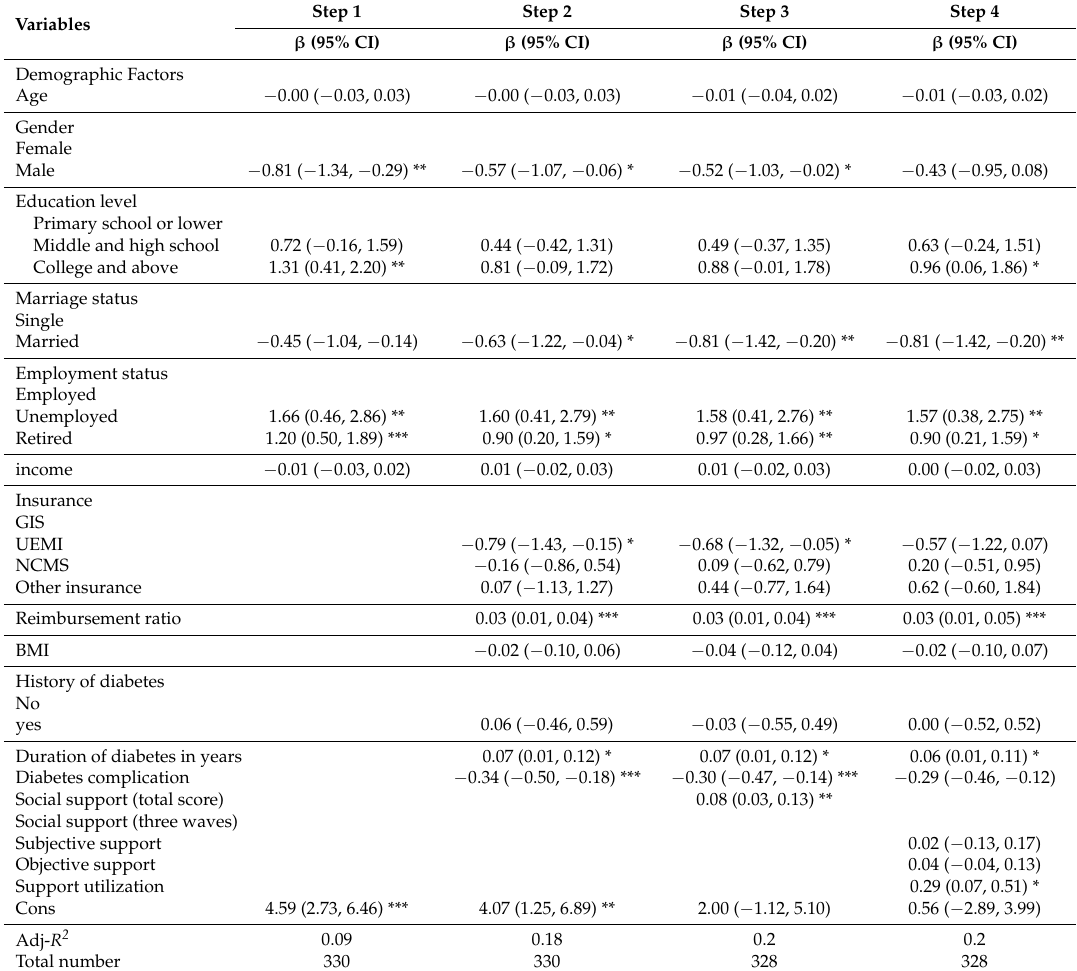
Table 2. Hierarchical multiple linear regression predicting medical